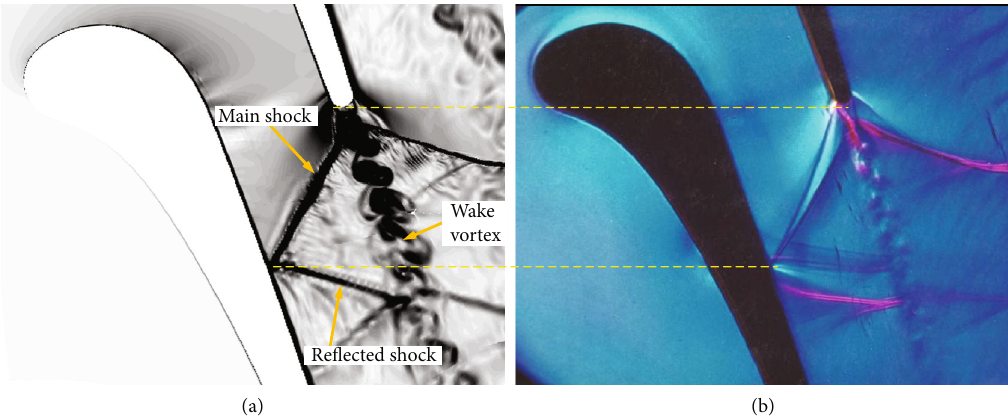
= 1 : 16 : (a) present SAS; (b) experimental schlieren [20]. ex